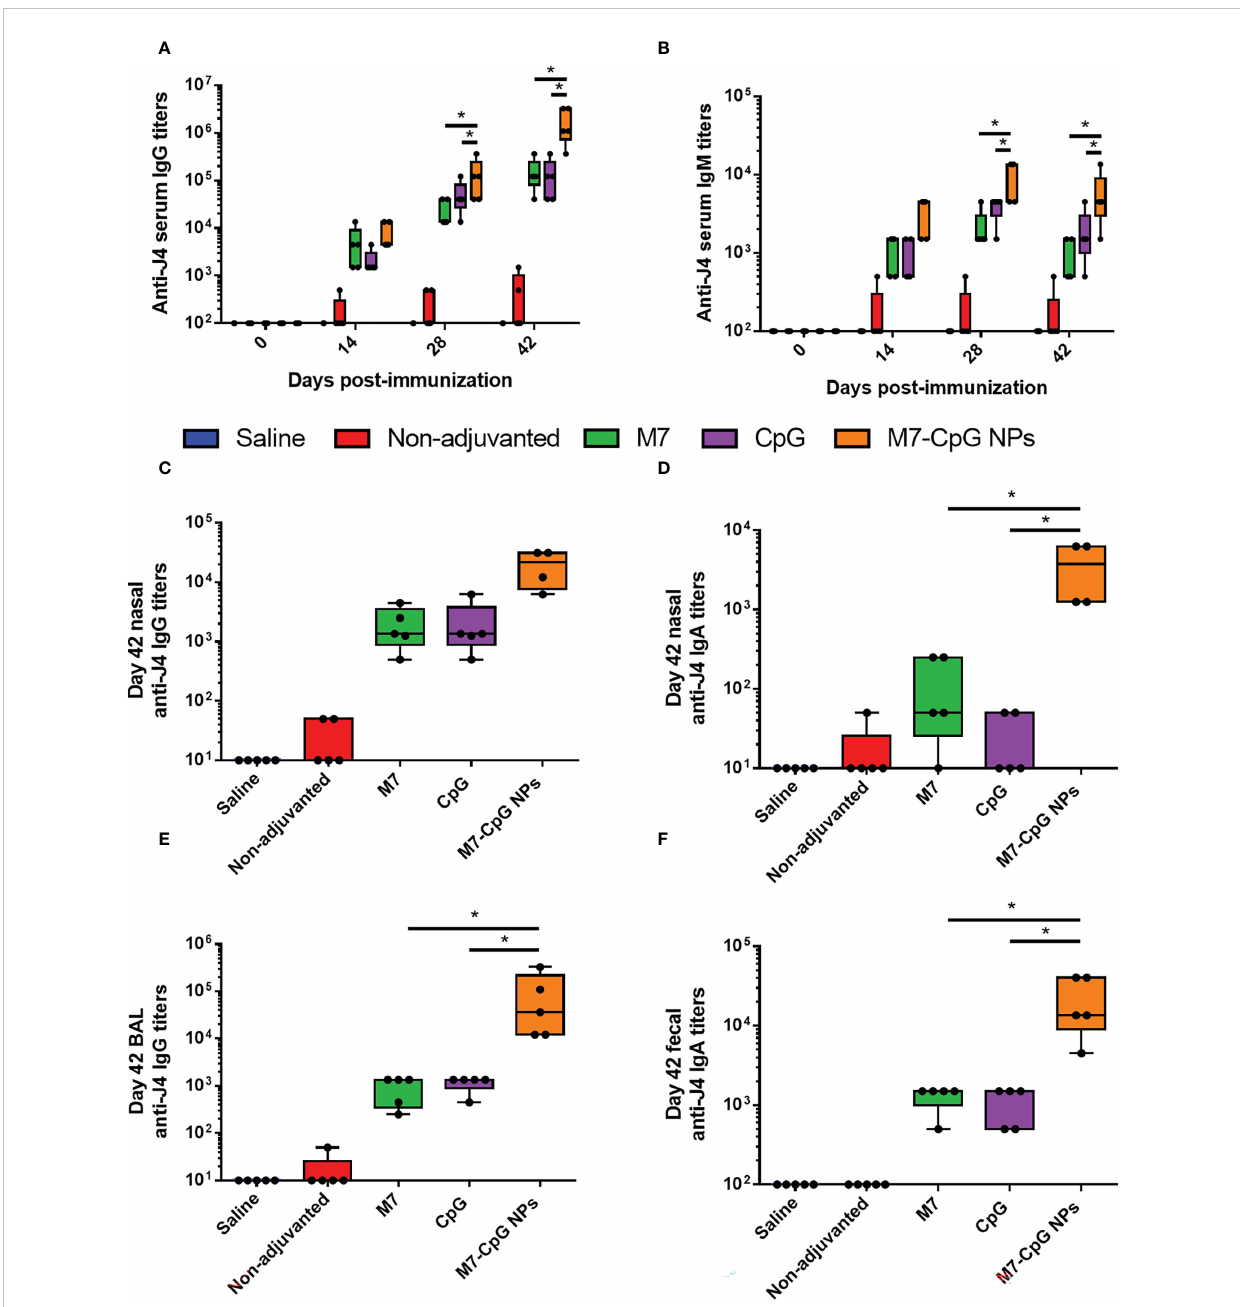
FIGURE 4 M7-CpG NPs improve the serum and mucosal antibody response against the COBRA in fl uenza antigen J4. C57BL/6 mice were intranasally immunized with saline, non-adjuvanted J4, M7 + J4, CpG + J4, or M7-CpG NPs + J4 on days 0, 21, and 35. (A) J4-speci fi c IgM and (B) total IgG titers on days 0, 14, 28, and 42 post-immunization. (C) J4-speci fi c total IgG and (D) IgA titers in nasal wash on day 42 post-immunization. (E) Total IgG titers in bronchoalveolar lavage (BAL) and (F) IgA titers in feces on day 42 post-immunization. Data are presented as mean ± range ( n = 5) (representative plots of two independent experiments). Signi fi cant differences were determined using a one-way ANOVA test with Tukey ’ s multiple comparison on the data shown (* p ≤